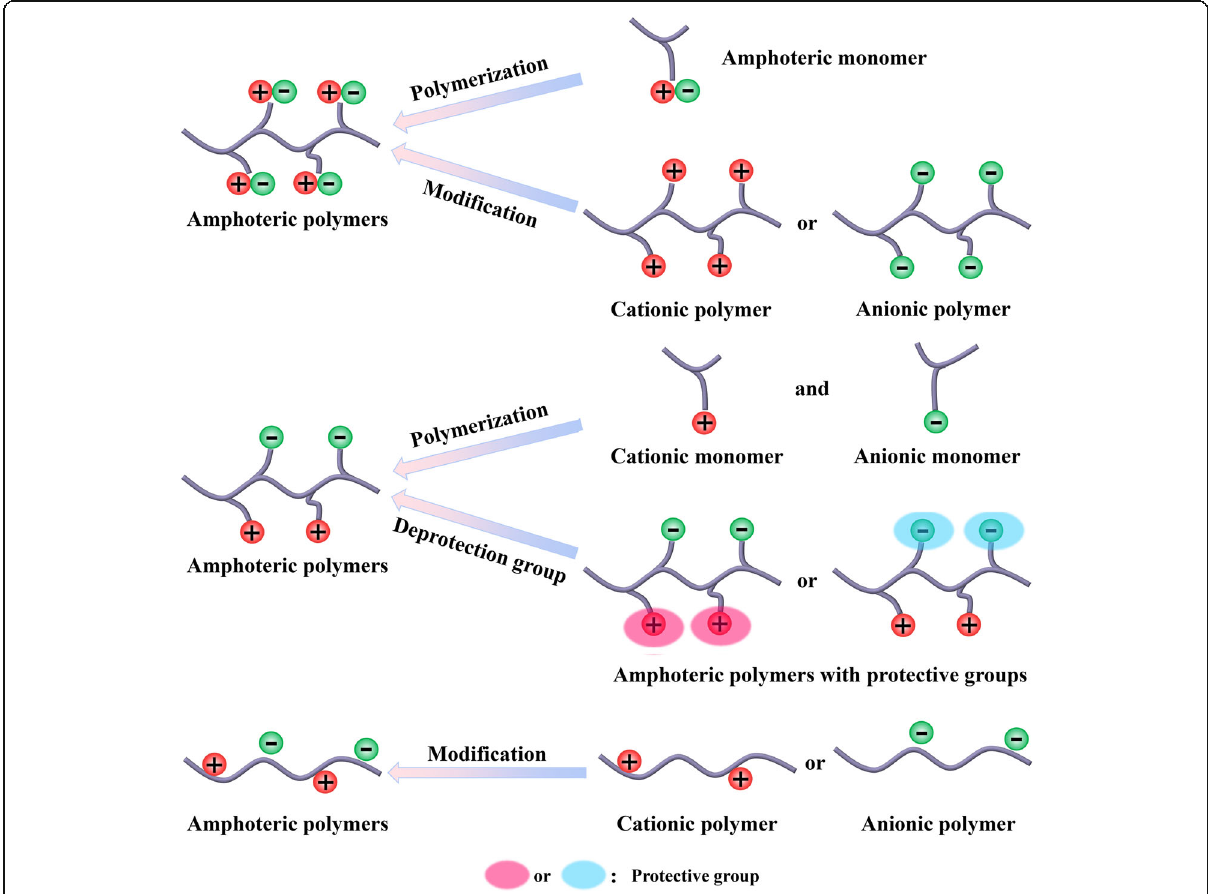
Fig. 1 Schematic diagram of the synthesis method of amphoteric